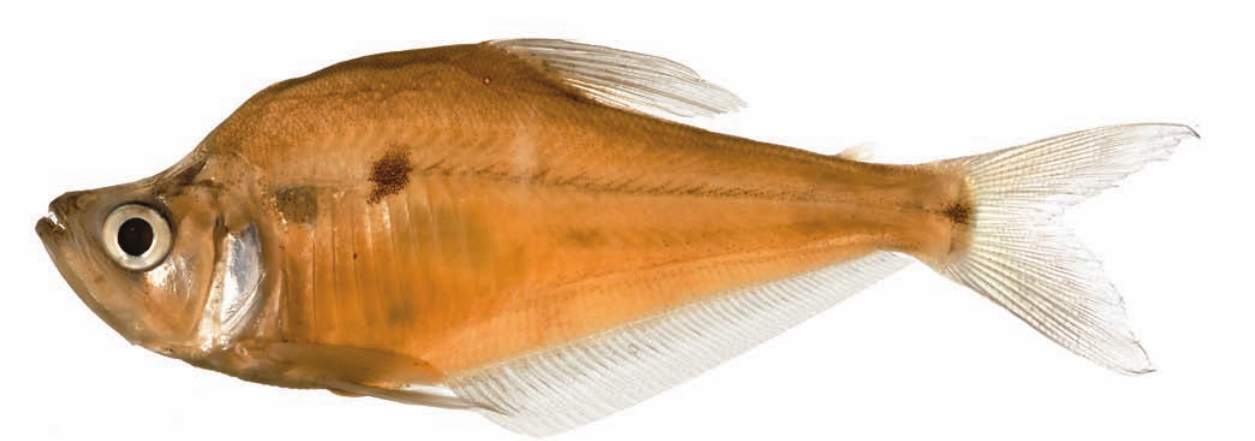
Fig. 21. Charax notulatus , USNM 260305, female, paratype, 77 mm SL, Venezuela, Guárico, 5 km N of RPV 83-4, río